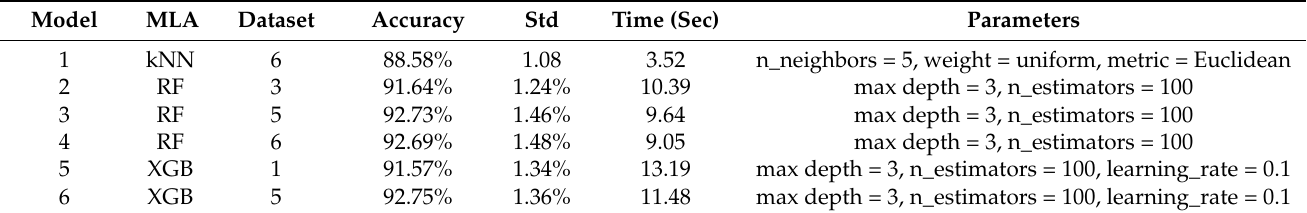
Table 10. Best performing models (first testing stage).